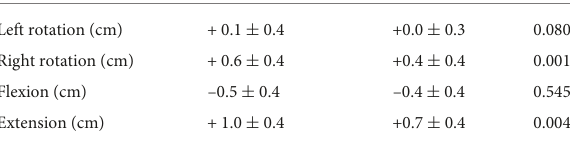
TABLE 6 Magnitude of the ETT tip movement grouped by the ETT